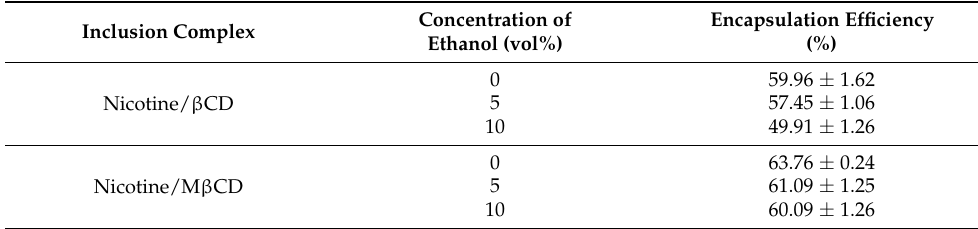
Table 2. Encapsulation efficiency of CDs with varied ethanol contents used for inclusion complex preparation.